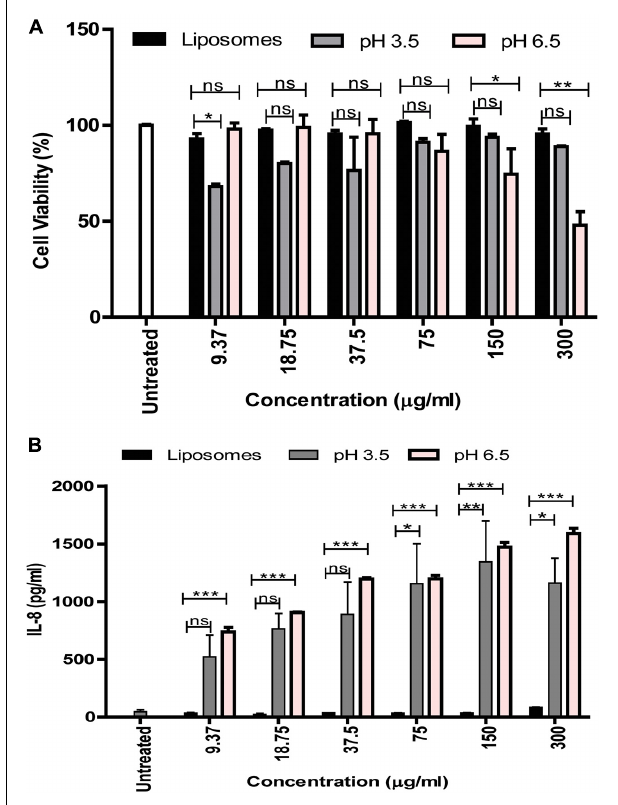
FIGURE 7 | Effect of G. vaginalis MVs obtained at pH 6.5 and pH 3.5 on the viability and cytokine induction by vaginal epithelial cells. Cell viability (A) and induction of IL-8 (B) by VK2 cells in response to treatment with pH 6.5 and pH 3.5 MVs (9.37–300 µ g/ml). BSA entrapped liposomes served as control and was used at protein concentrations similar to that of the MVs. Data are presented as mean ± SD. Statistical analysis was done using two-way ANOVA with Bonferroni test * p < 0.05; ** p < 0.01; *** p < 0.001; and ns,